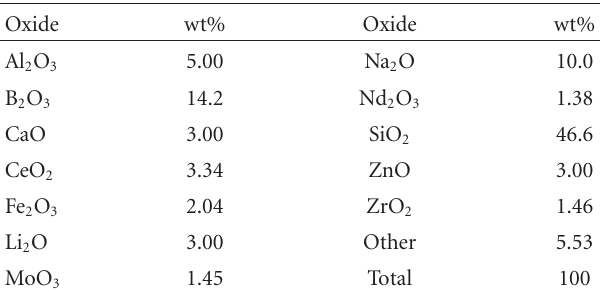
Figure 1: pH of the leachates versus time for DIW test and for MgCl 2 solution tests. Table 1: A chemical composition of P0798 type simulated HLW